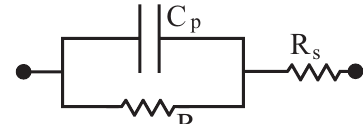
> 0 to counter the flow of pa > V . pa p